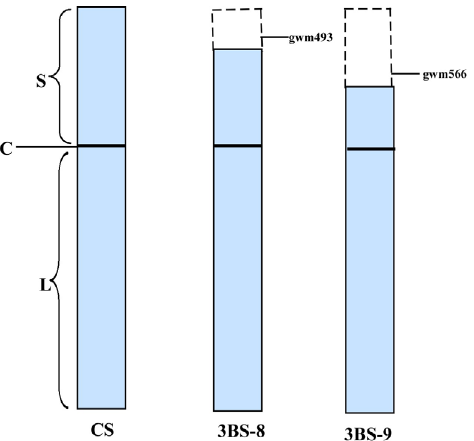
Figure 1. Diagrams of 3B chromosome of Chinese Spring (CS) and its fine deletion lines. The dashed boxes indicated the deleted chromosome segments gwm493 and gwm566.